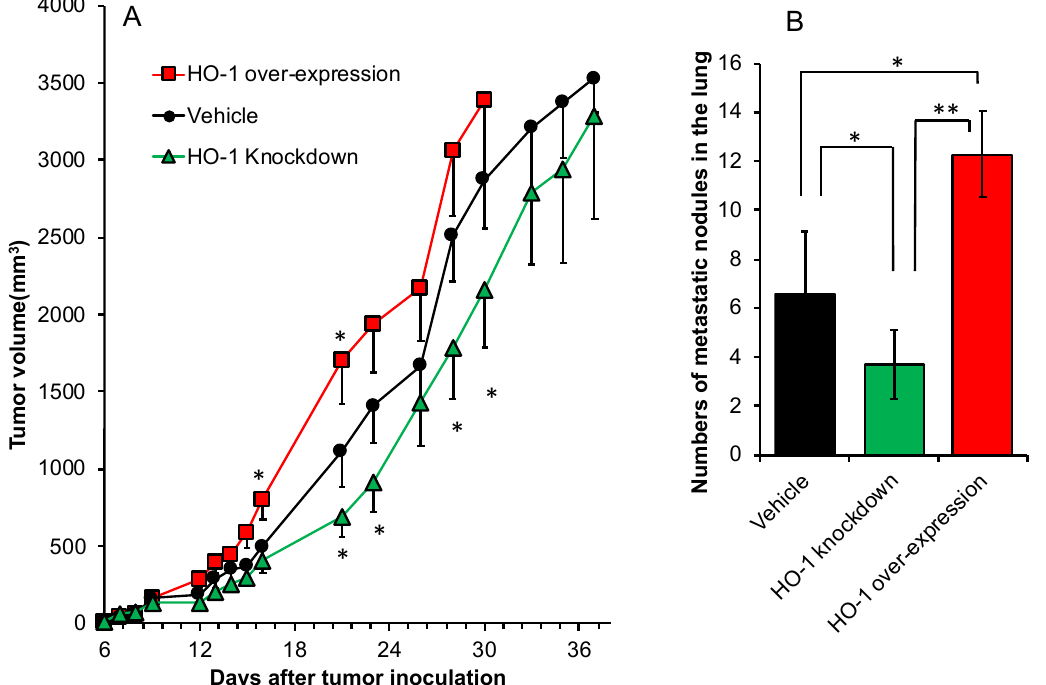
Figure 5. In vivo tumor growth of C26 cells with different expression levels of HO-1 in Balb/c mice. Wide C26 cells (transfected with lentivirus, vehicle), as well as C26 cells with HO-1 over-expression and HO-1 knock-down, were used in this study. After tumor inoculation, tumor volumes were measured every 2–3 days ( A ). At 40 days after tumor inoculation, mice were killed, and the lungs were collected. Tumor nodules in the lung were identified macroscopically, and numbers of metastatic nodules and each diameter were counted ( B ). Data are mean ± SEM, n = 6–8. * p < 0.05; ** p < 0.01. See text for details.